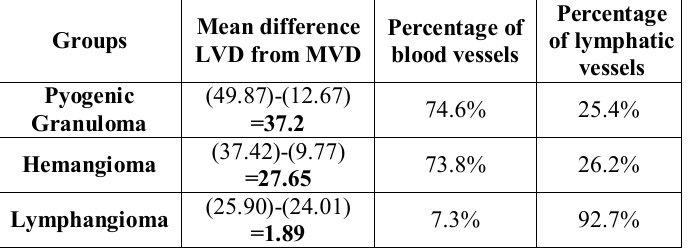
Table 3: Mean difference of LVD from MVD and the percentage of lymphatic and blood vessels in hemangioma, pyogenic granuloma and lymphangioma